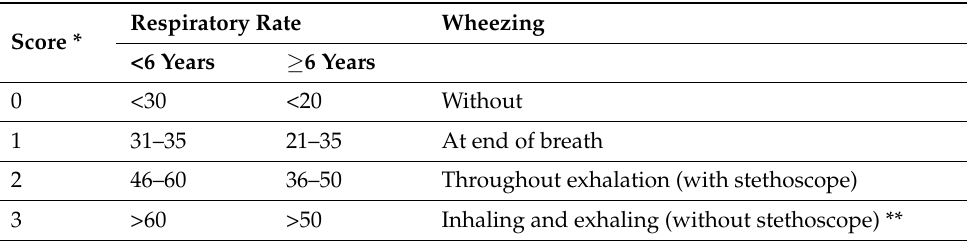
Table 1. Lung score for clinical assessment of asthma exacerbation in children according to the Spanish Guidelines for Asthma Management GEMA 5.0 [3].